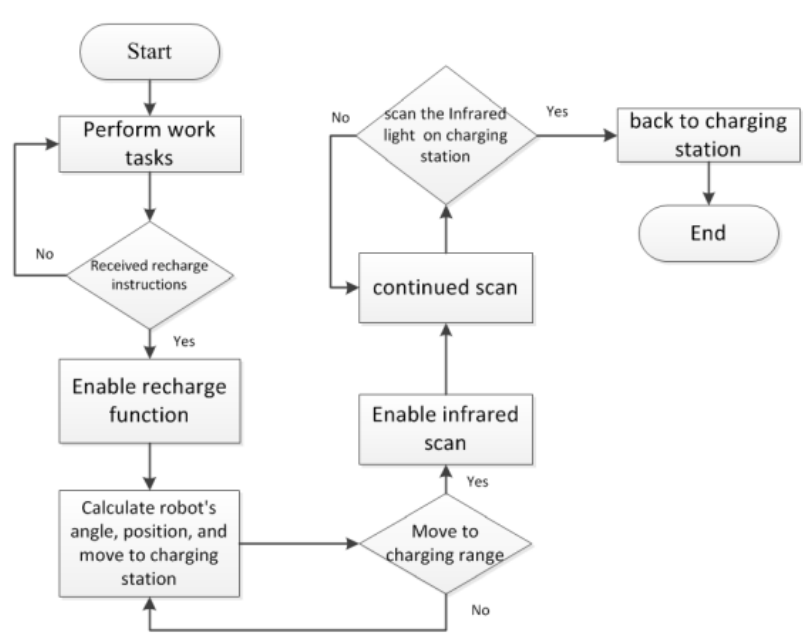
Figure 19. Auto-recharging mechanism for cleaning robot. Figure 19 . Auto-recharging mechanism for cleaning robot.